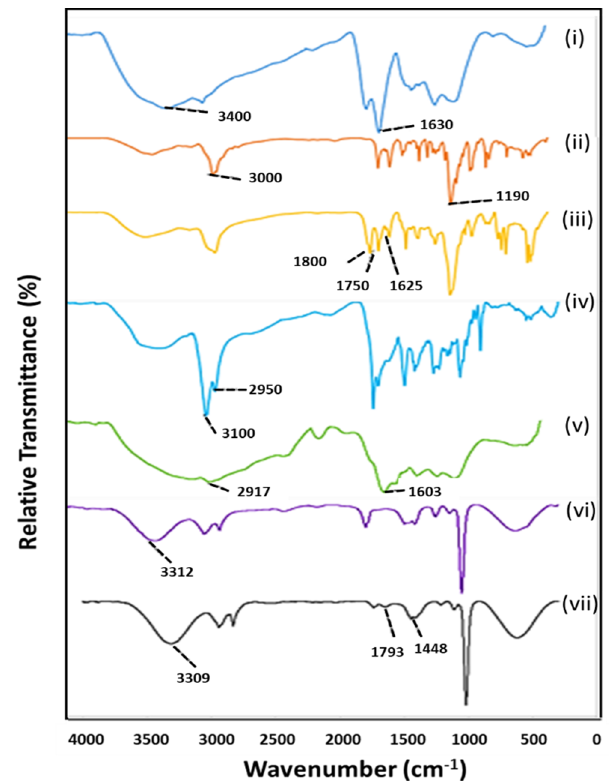
Figure 3. FTIR of nanoparticles showing changes in bond vibrations of respective functional groups. ( i ) AuNP, ( ii ) Au-PEG, ( iii ) T-Au-PEG, ( iv ) T-Au-PEG-BA, ( v ) Au-[PLL-g-PEG], ( vi ) T-Au-[PLL-g-PEG], ( vii ) T-Au-[PLL-g-PEG]-BA.